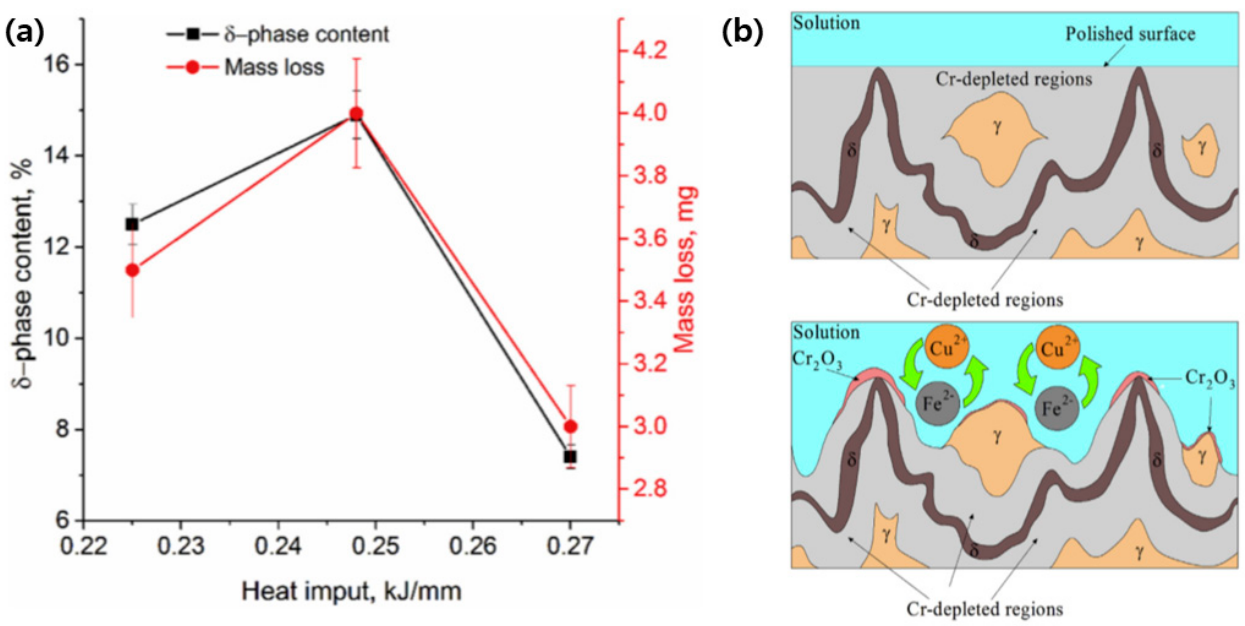
Figure 11. ( a ) δ -ferrite content and corrosion mass loss as functions of heat input; ( b ) schematics to show passivation film formation on δ -ferrite and austenite grains, as well as corroded surface morphology [70].